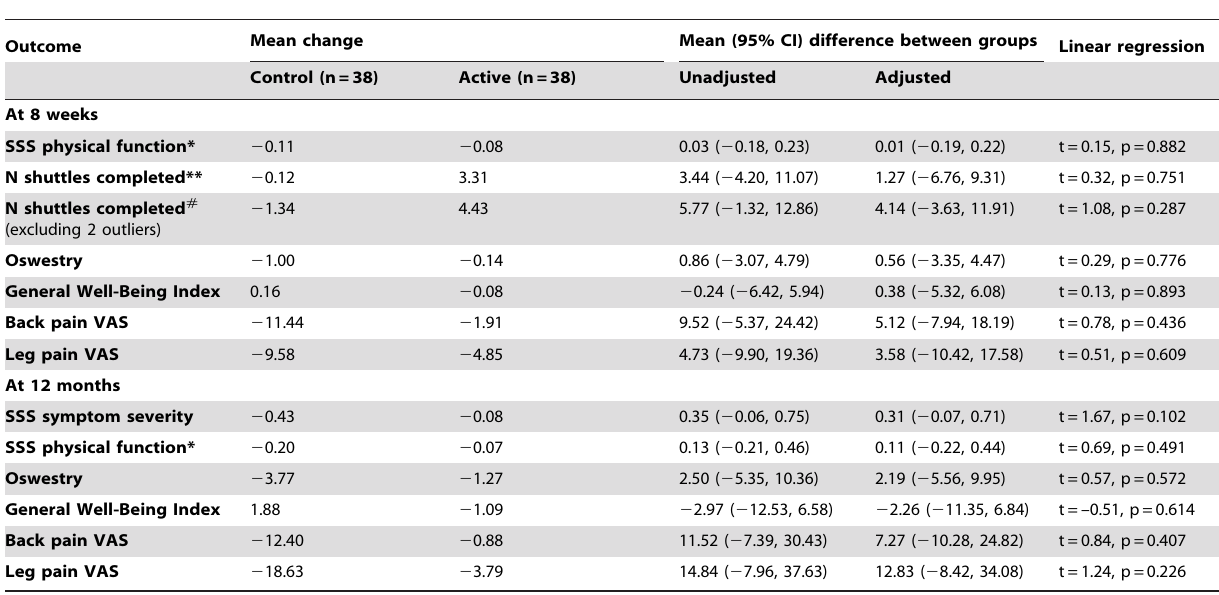
Table 4. Changes in secondary and exploratory outcomes at eight weeks and 12 months – unadjusted values and baseline- adjusted results.